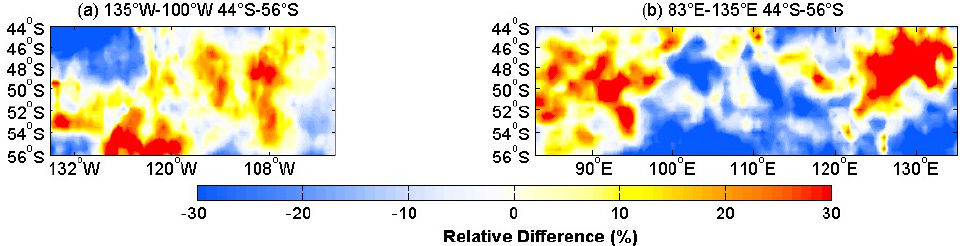
Figure 6. ( a ) The relative differences of the whitecap coverage over the western part (44 ◦ S–56 ◦ S, 135 ◦ W–100 ◦ W). RD = ( W mod − W obs ) / W obs × 100, RD is the relative difference, W mod is the whitecap coverage of the model, W obs is the whitecap coverage of the satellite-derived data, and ( b ) is the relative differences over the east part (44 ◦ S–56 ◦ S, 83 ◦ E–135 ◦ E). Table 5. Maximum and mean whitecap coverage over the western part (135° W–100° W, 44° S–56° S).